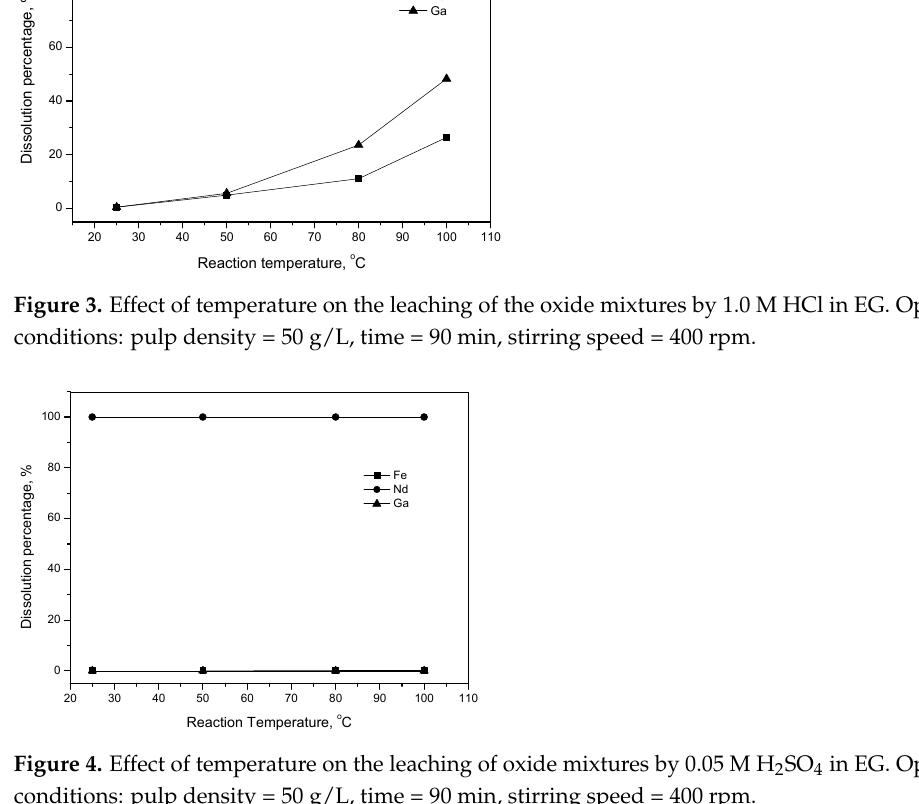
Fe Nd Ga Figure 6. Effect of time on the leaching of oxide mixtures by 0.05 M H 2 SO 4 in EG. Operation condi- tions: pulp density = 50 g/L, T = 25 °C, stirring speed = 400 rpm. 3.4. Effect of Pulp Density Pulp density is usually expressed as the ratio of the mass of the solid reactant to the volume of the leaching agent (g/L). In general, the use of larger amounts of leaching solu- tion increases the dissolution performance [30,31]. Pulp density was varied from 50 to 150 g/L at room temperature and at a stirring speed of 400 rpm. In experiments with 1.0 M HCl in EG and 0.05 M H 2 SO 4 in EG, reaction times were fixed at 120 and 60 min, respec- tively. Figures 7 and 8 show the same trends in both acids, namely, that lower pulp density enhances the selective dissolution of Nd 2 O 3 , whereas dissolution percentage decreases at higher pulp density. Nd 2 O 3 was completely dissolved at a pulp density of 50 g/L but de- creased to 61% as the pulp density increased to 150 g/L (Figure 7). In these experiments, the dissolution percentage of Fe 2 O 3 and Ga 2 O 3 was only 0.4% irrespective of the pulp den- sity (Figure 7). In the H 2 SO 4 /EG system, the dissolution of Nd 2 O 3 decreased from 100% to 87% when the pulp density increased from 50 to 150 g/L, and there was no dissolution of Fe 2 O 3 and Ga 2 O 3 (Figure 8). The lower pulp density was beneficial in the selective and complete dissolution of Nd 2 O 3 . Therefore, it can be said that the optimum pulp density for the complete dissolution of Nd 2 O 3 using HCl and H 2 SO 4 solution was 50 g/L.